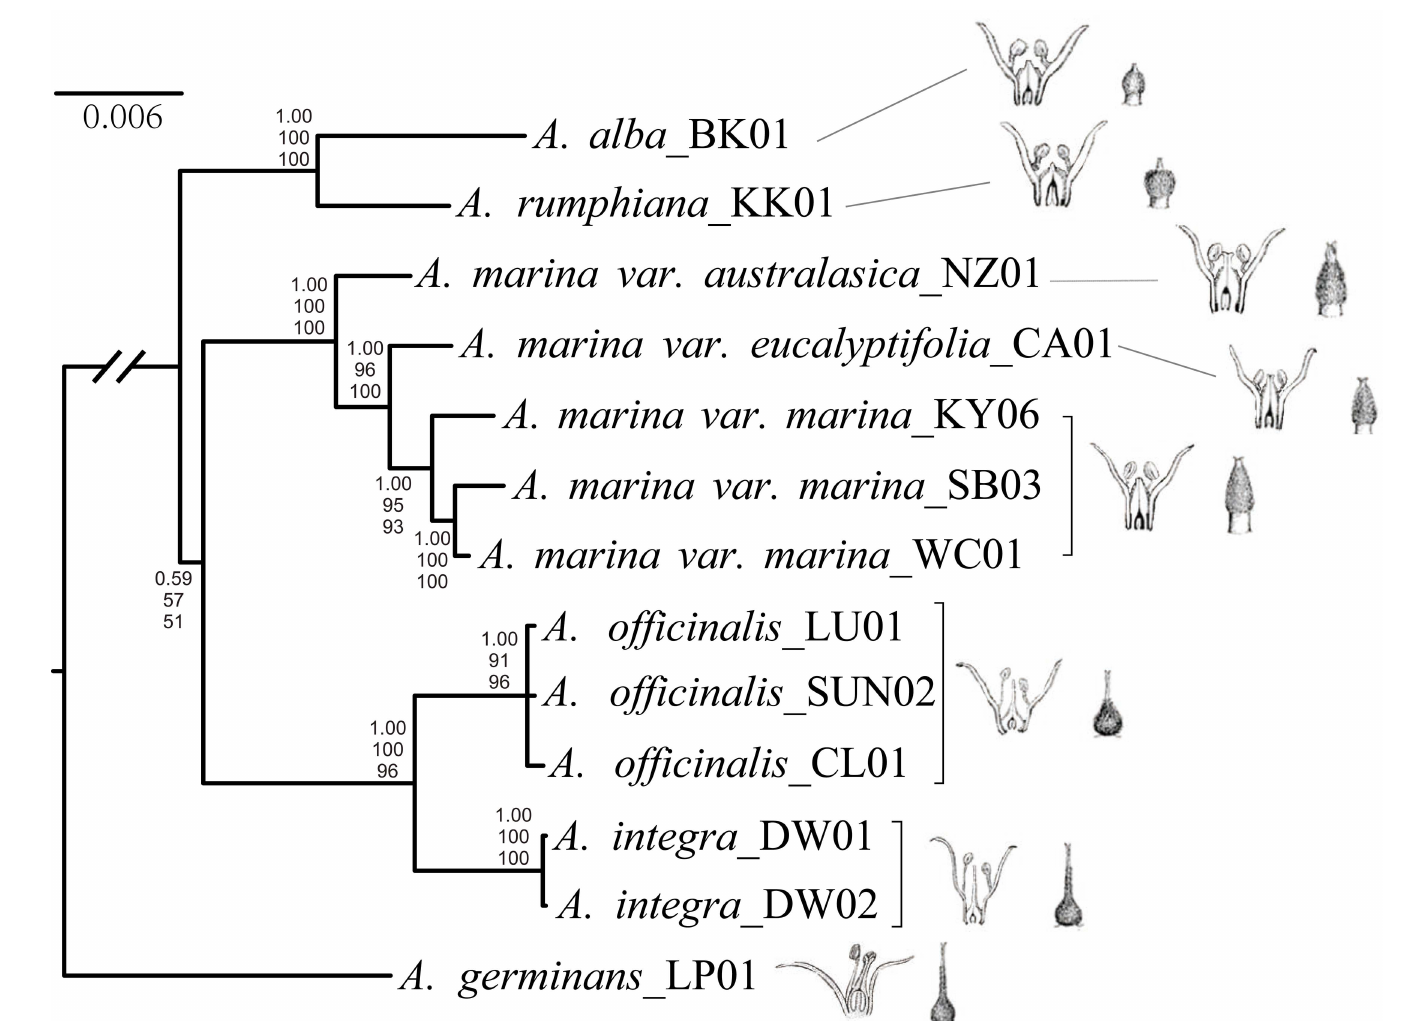
Fig 2. Bayesian Inference tree of Avicennia species in the Indo-West Pacific (IWP) region. Based on concatenated sequencesof 25 nuclear genes, with A. germinans as the outgroup. Bayesian posterior probabilitiesfor Bayesian Inference (BI), Likelihoodbootstrap values from the maximum likelihood analysis (ML) and Parsimony bootstrap values from maximum parsimony analysis(MP) are indicatedat nodes (BI/ML/MP). Two selected morphological characters of taxonomic importance(source from [1]) have been mappedon the